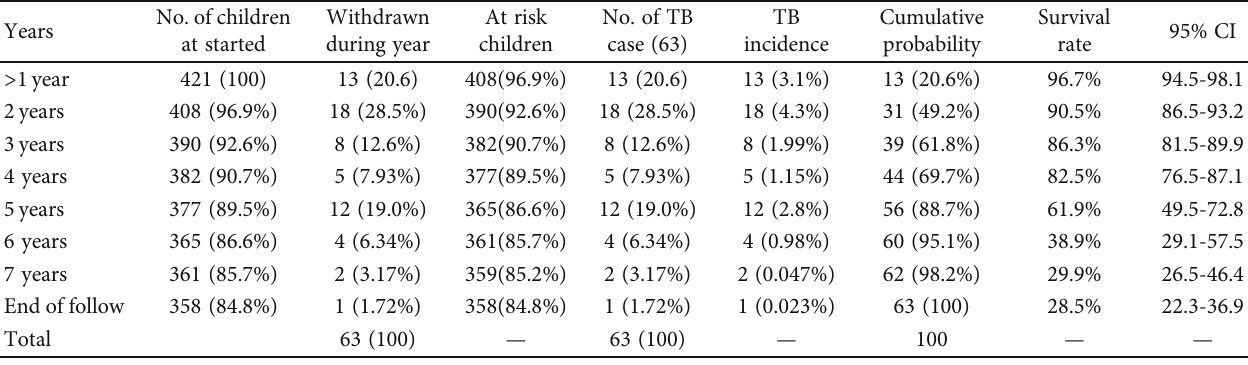
Table 3: Time to developed TB incidence for seropositive children attending HIV/AIDS care in public hospitals between January 2011 and December 31/2020, North West Ethiopia ( N = 421 ).